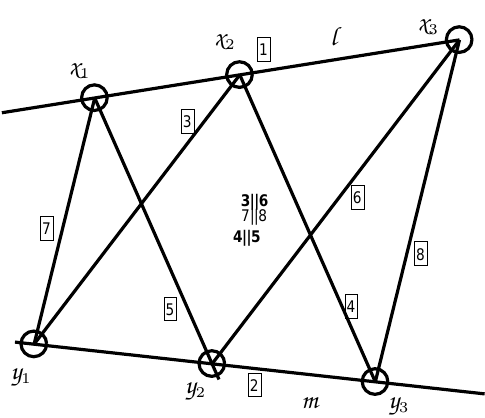
Figure 5. Pappus’s hexagon with three collinear intersection points in the middle. In particular, the constraints ‘7 (cid:107) 8’ and ‘ (cid:12) (9 , 10 , 11) ’ are redundant. currence and three times